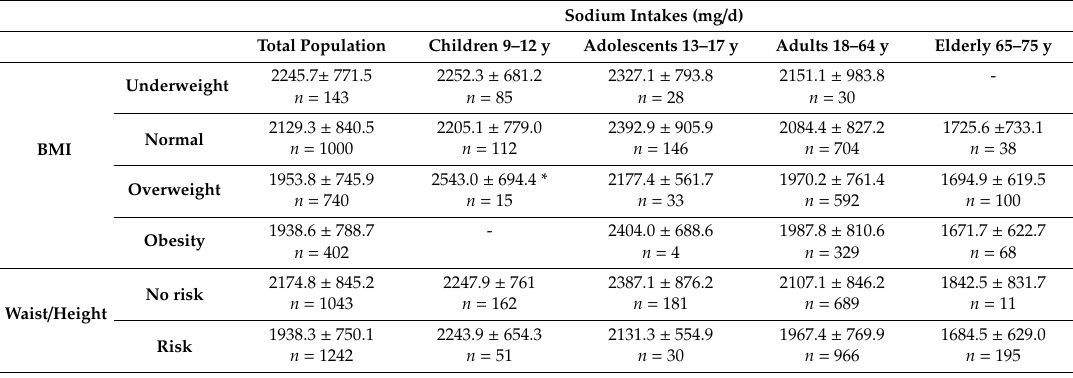
Table 5. Sodium intakes according to body composition and physical activity amongst the ANIBES study population.